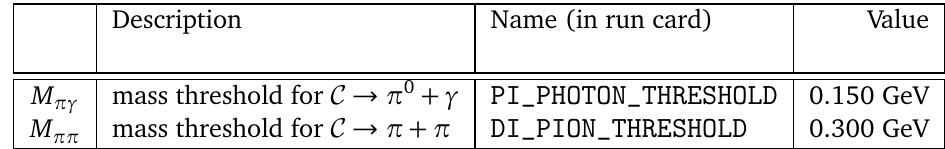
Table 6: Fixed mass thresholds for light cluster to hadron